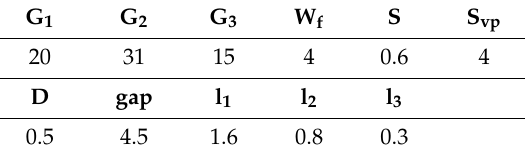
Figure 2. Equivalent circuit model of the unit cell. Table 1. Dimensions of the unit cell(unit:mm).